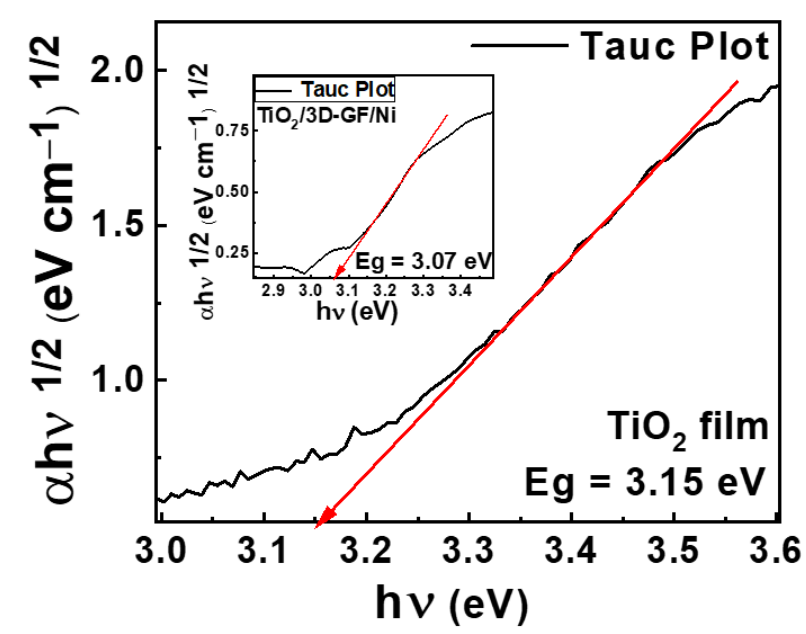
Figure 5. Tauc plot (black line) of TiO 2 film deposited on quartz and 3D-GF (inset) indicating the TiO 2 band gap estimated by extrapolation of the linear region (red line) to the abscissa .